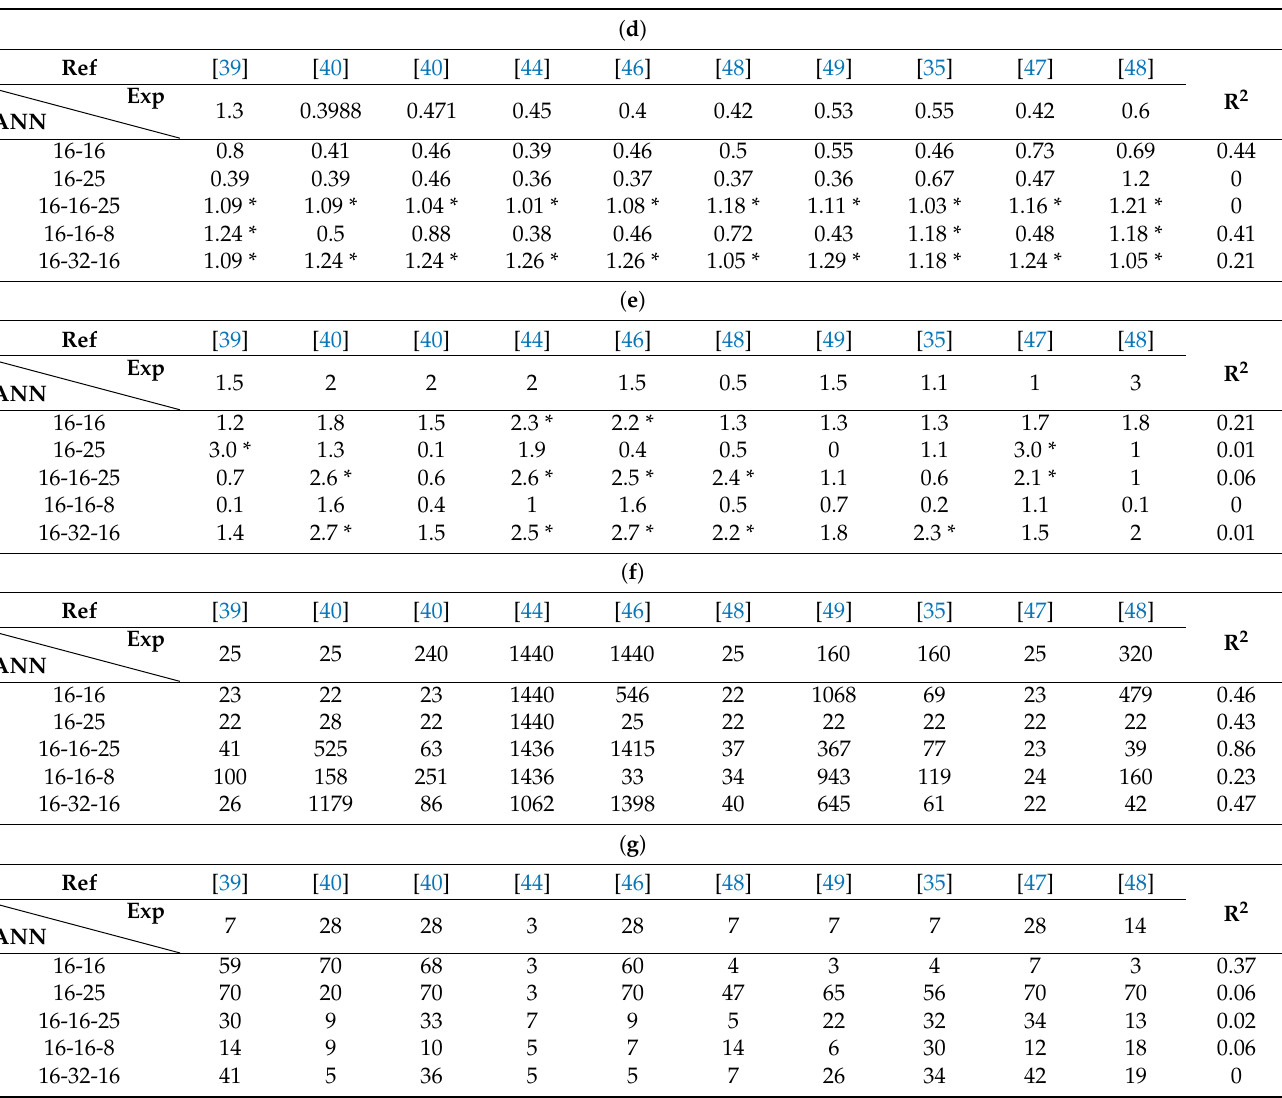
The fly ash content was predicted with the maximum accuracy of 75% with ANN [2:16:16:7] model upon regression analysis with the validation dataset, as shown in Figure 5a. The highest prediction accuracy was obtained with the sand content prediction with the same ANN model with an accuracy of 85%. Similarly, looking upon GGBS prediction with the same ANN model, it was observed to be 48%, which is quite phenomenal. Thus, it is inferred that ANN [2:16:16:7] model performs well in predicting the material contents. The material contents and their proportion form the major part of the mix design and it is suggested to use the model in determining the mix proportion of binding and aggregate materials. As per Figure 5a of the perfect line analysis, it is observed that most of the predictions fall within the ± 20%